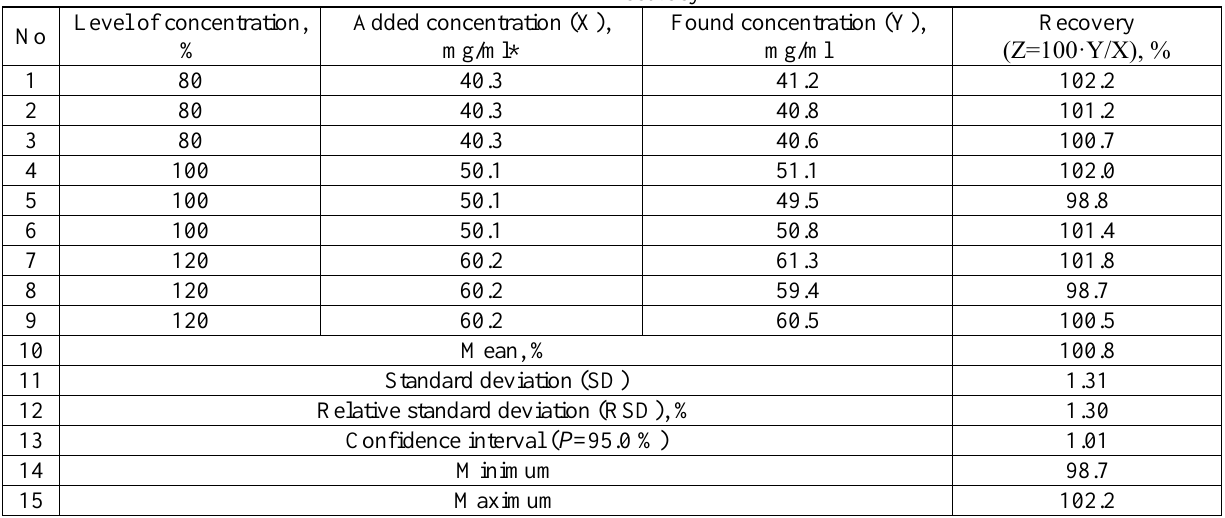
Fig. 7. Linear regression of the dependence of the area of aminocaproic acid derivative on its concentration in the solution